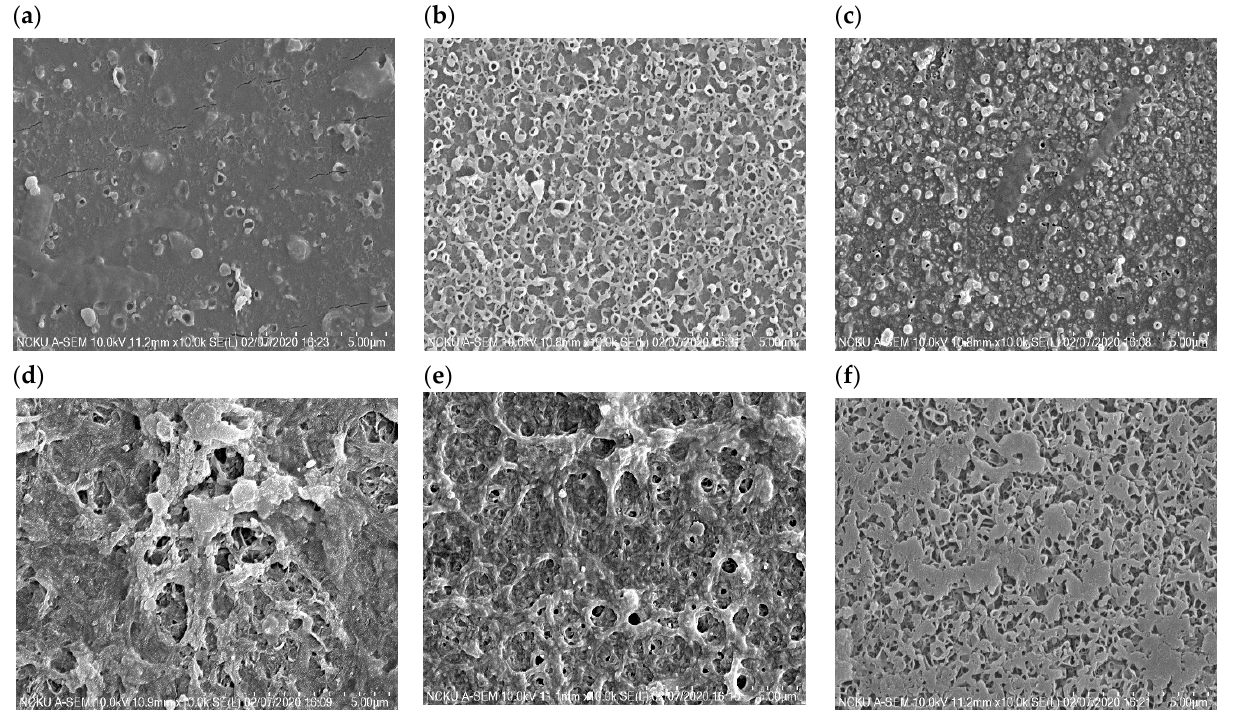
Figure 6. Top surface morphologies of the TFN membranes using ( a ) CPA (0.2 wt.%), ( b ) CPB (0.2 wt.%), ( c ) CATCP (0.1 wt.%), ( d ) CBTCP (0.2 wt.%), ( e ) CATCP—TiO 2 (0.1 and 0.1 wt.%, respectively), and ( f ) CBTCP—TiO 2 (0.2 and 0.1 wt.%, respectively).